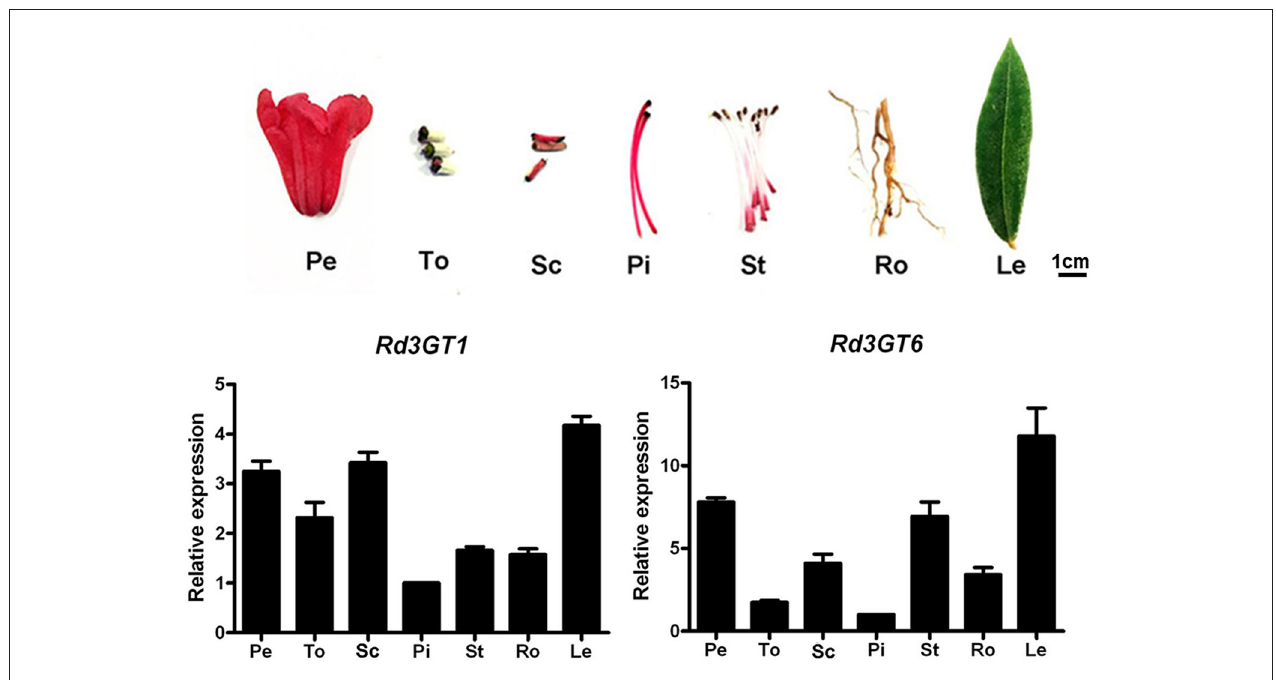
FIGURE 4 | Expression profiles of Rd3GT1 and Rd3GT6 in different tissues of R. delavayi . Pe, petals; To, toruses; Sc, scapes; Pi, pistils; St, stamens; Ro, roots; Le,